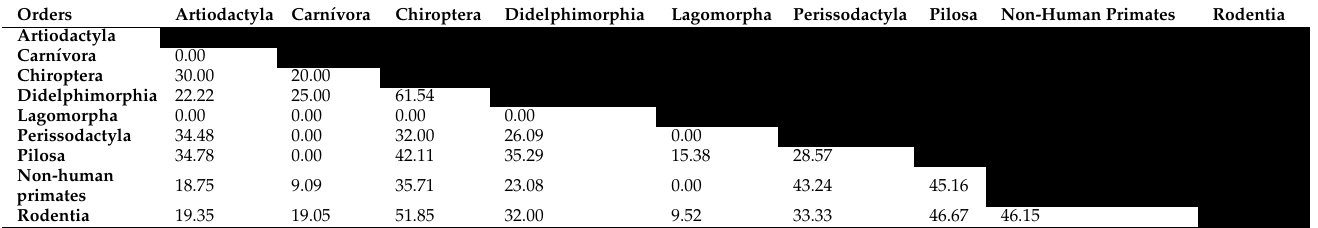
Table 4. Similarity index according to Sorensen’s index among mammalian orders in the